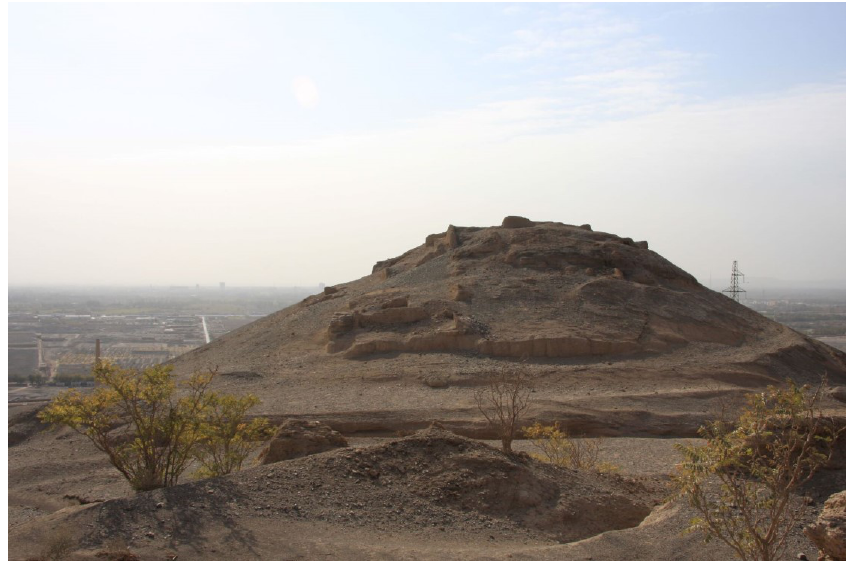
Figure 1 The monastery site at Shuïpang near Bulayïq, Turfan (photo by Erica D.